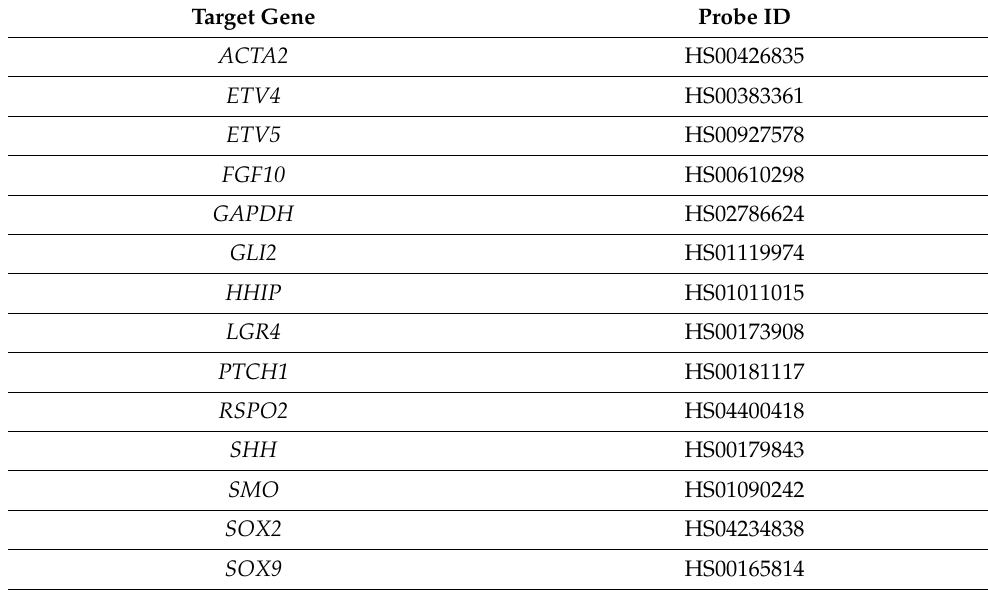
Table 1. Taqman TM probes used for RT-qPCR. Target